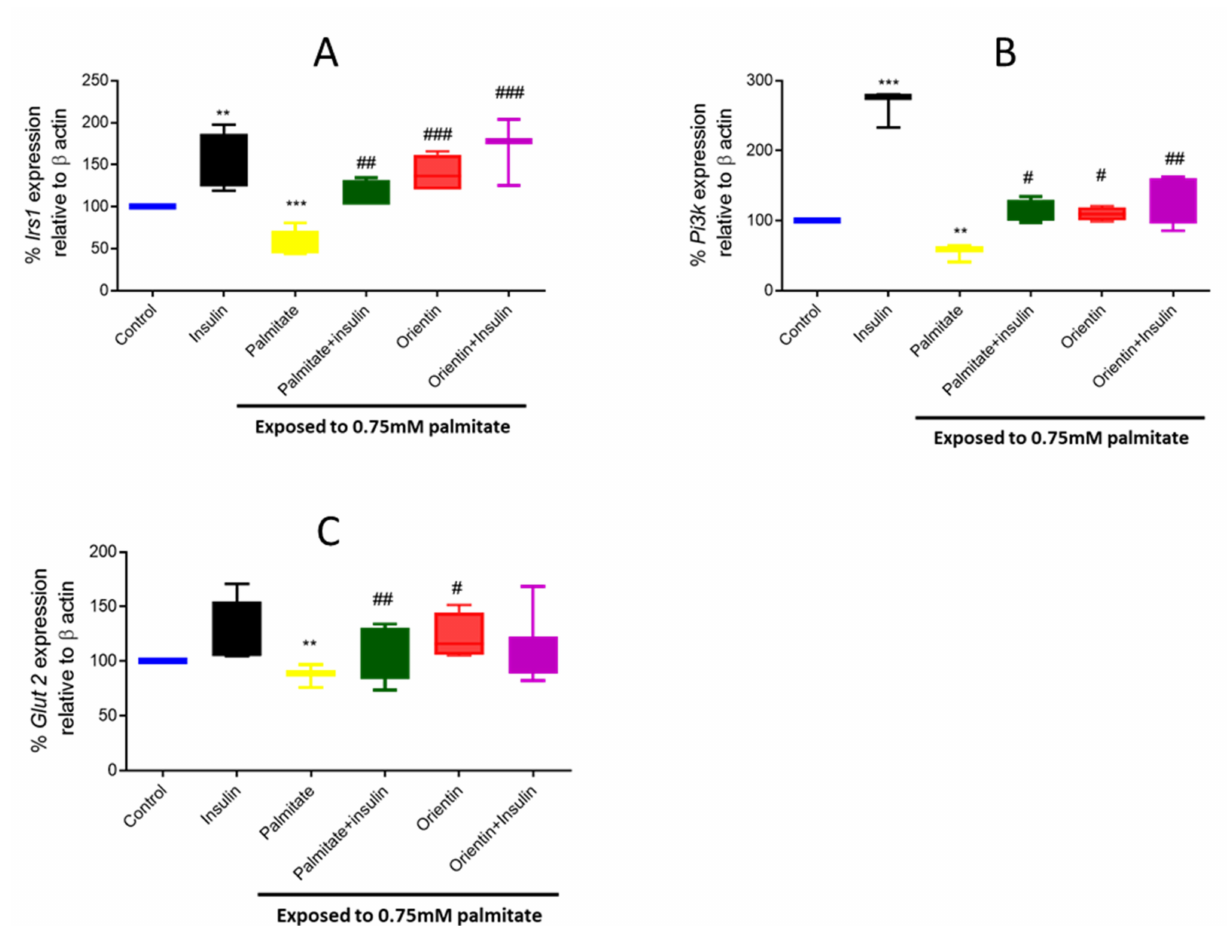
Figure 3. Effect of orientin on the expression of different genes involved in insulin signaling such as insulin receptor substrate 1 ( Irs1 ) ( A ), phosphatidylinositol 3 kinase ( Pi3K ) ( B ) and glucose transporter 2 ( Glut2 ) ( C ) in C3A liver cells exposed to high (0.75 mM) palmitate concentrations. Briefly, insulin resistance was induced with 0.75 mM of palmitate for 16 h in C3A liver cells, followed by treatment with or without 10 µ M of orientin for 3 h and 1 µ M of insulin. Thereafter, gene expression was investigated using qPCR. Results are expressed as mean ± SD of 3 independent experiments. The bars depict statistical differences at ** p < 0.01, *** p < 0.001, versus the experimental control set at 100% and # p < 0.05, ## p < 0.01, ### p < 0.001 versus palmitate